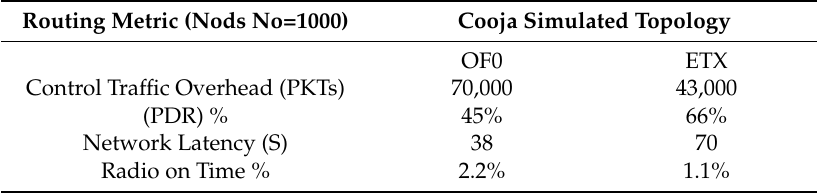
Table 5. RPL routing metrics results within cooja simulator measured over the simulation time. Routing Metric (Nods